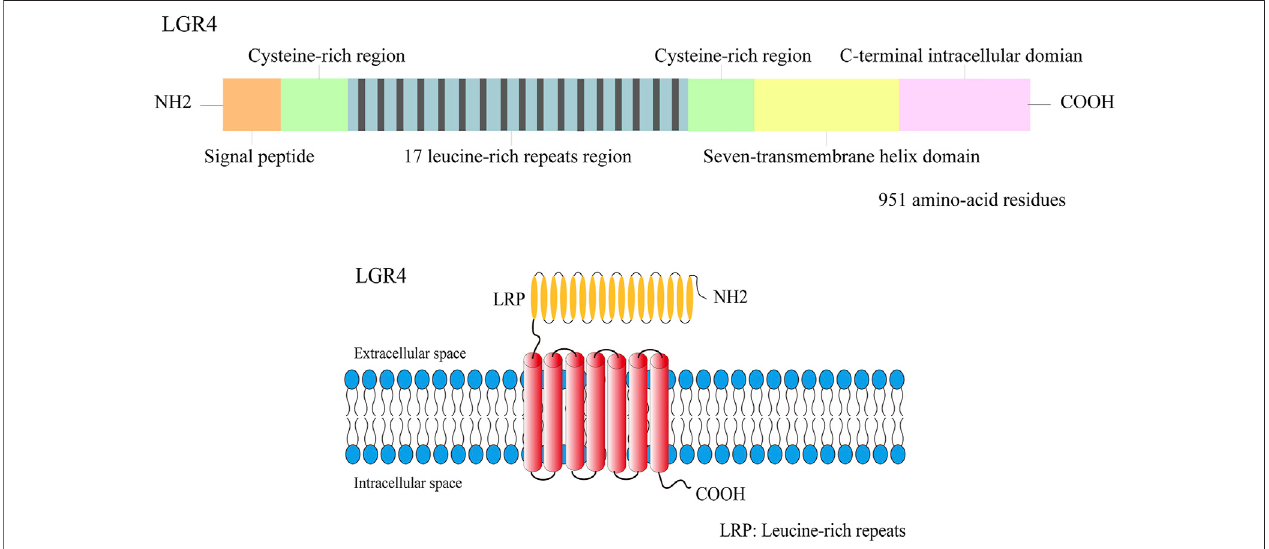
FIGURE 1 | The structure illustration of the LGR4 protein. LGR4 was a member of transmembrane receptor, its N-terminal domain was comprised of 17 leucine- rich repeats region which was fl anked by the N-/C- cysteine-rich regions. A seven-transmembrane domain and a C-terminal intracellular region were detected in